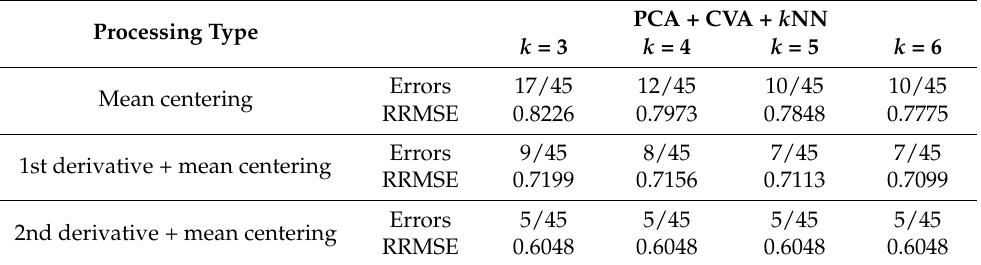
Table 10. Study No. 3 with NIR Spectral Data. Prediction-Set Classification Errors (45 Samples).